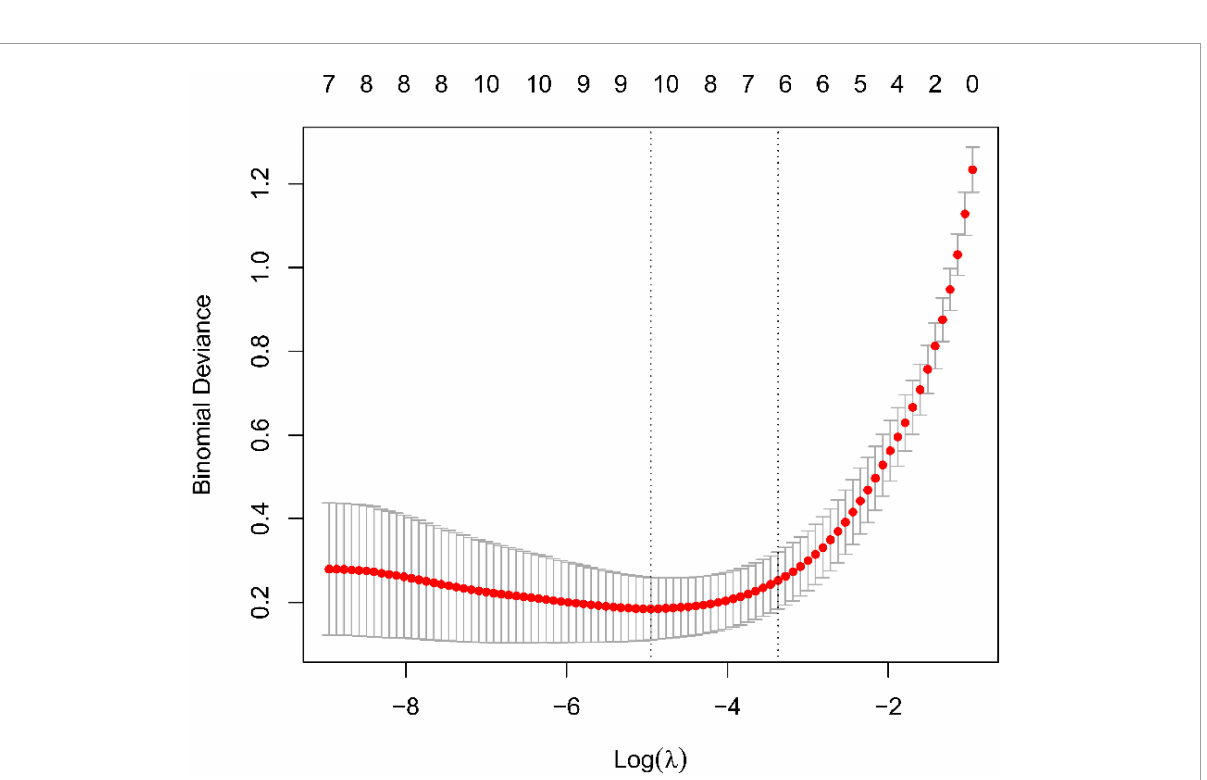
FIGURE5 DO enrichment analysis plot.